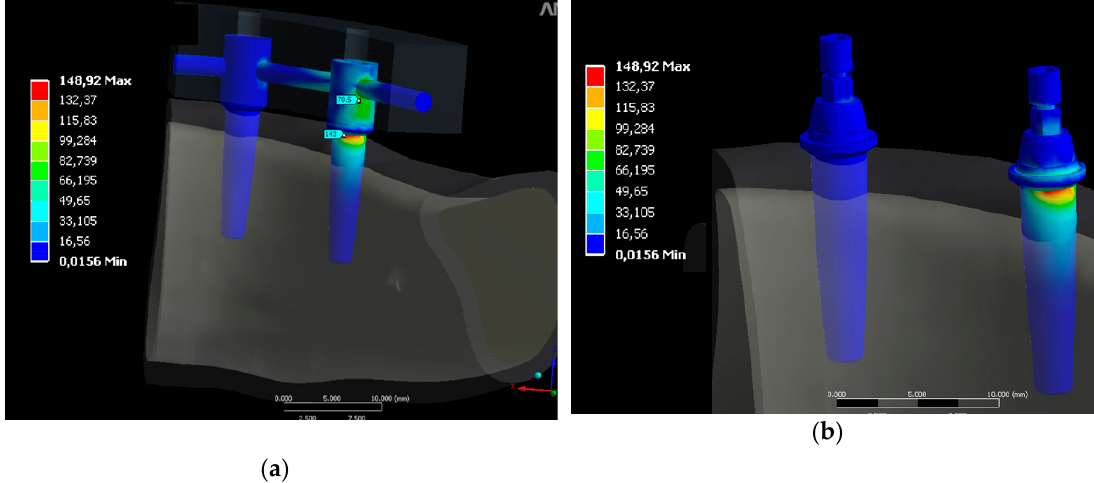
Figure 5. Von Mises stress on the implant, abutment, and metallic structure in MPa: ( a ) group M1; ( b ) group M2.